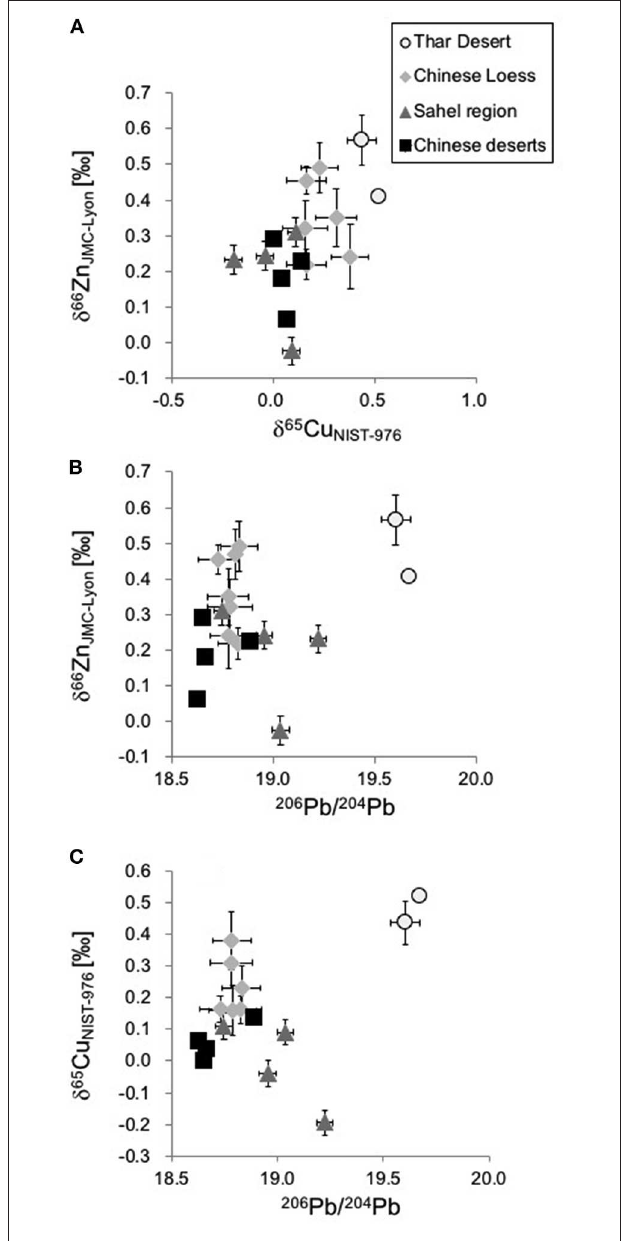
FIGURE 4 | Bivariate plots of the three isotope systems ( δ 66 Zn JMC − Lyon , δ 65 Cu NIST − 976 , and 206 Pb/ 204 Pb) in bulk samples. (A) δ 66 Zn JMC − Lyon